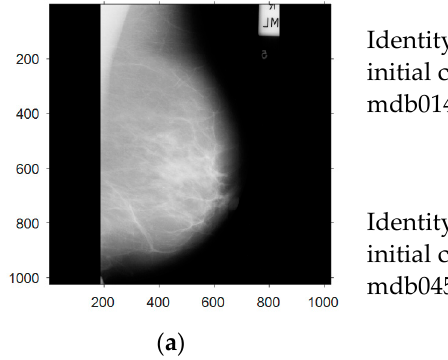
Figure 14. Extraction of identity with relevant and nonrelevant information. ( a ) Original mammogram of patient mdb014. ( b ) Identity retrieved by using information of mdb014. ( c ) Identity retrieved by using information of patient mdb045.